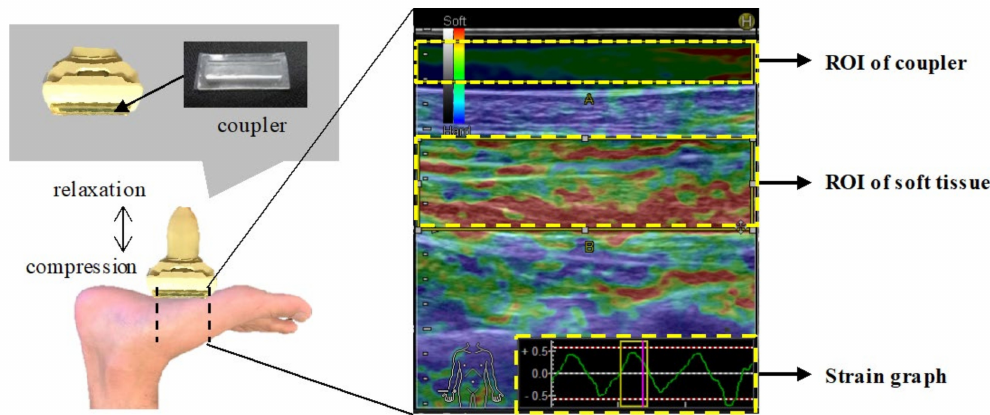
Figure 2. Assessment of muscle hardness using RTE and RTE images. We pressed the transducer against the selected soft tissue with constant repeated pressure (compression–relaxation cycle) by checking the strain graph. Subsequently, we selected the ROI of the coupler and soft tissue, and the strain ratio (muscle/coupler) was calculated. Abbreviation: RTE, real-time tissue elastography; ROI, region of